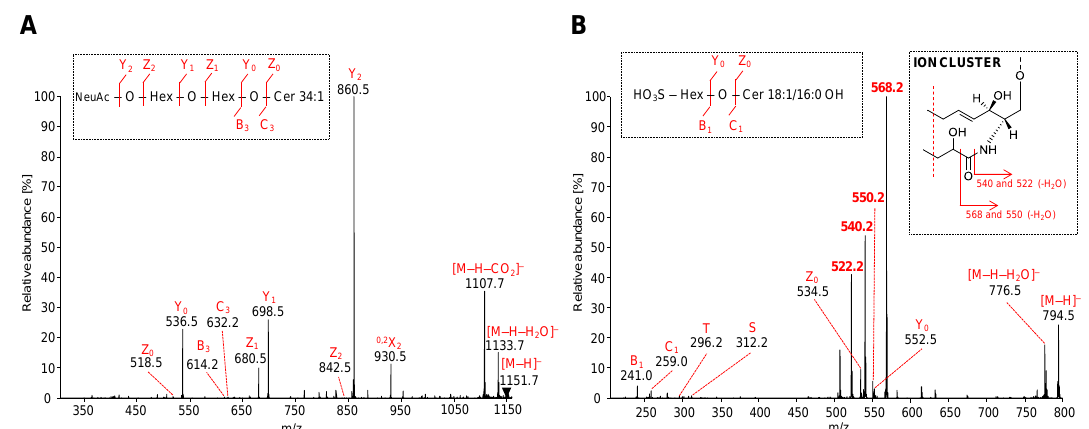
Figure 7. HILIC-ESI-MS/MS spectra of representative acidic GSL species: MS/MS spectra illustrate fragmentation pathways with specific product ions of ( A ) ganglioside GM 3 34:1 at m/z 1151.7, and ( B ) sulfatide SHexCer 18:1/16:0 OH at m/z 794.5.